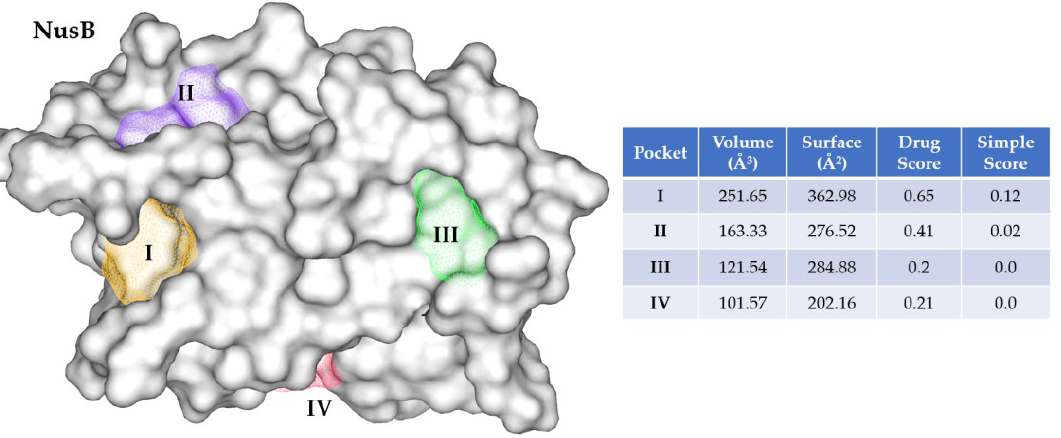
Table 7. XP docking scores of the identified hits to NusB, and their corresponding binding free en- ergy calculated by Prime MM-GBSA module in Maestro 10.2